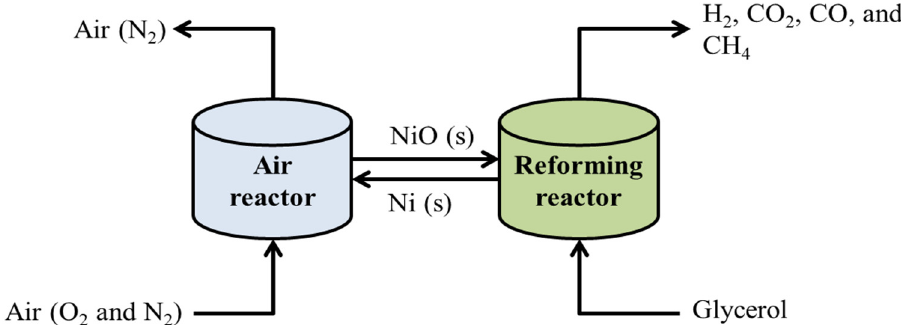
Figure 5. A schematic diagram for chemical looping steam reforming using NiO as the oxygen carrier [46].